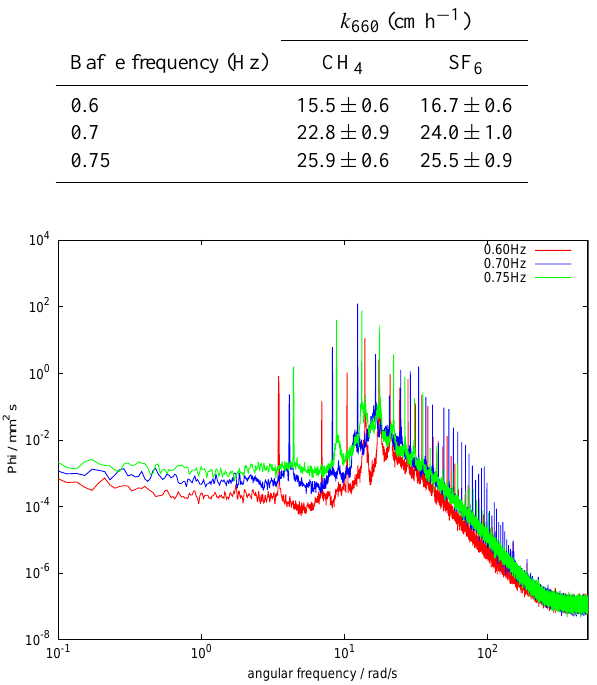
Figure 9. Wave spectra of a typical gas exchange experiment with Milli-Q water. The first peak for each boundary condition corre- sponds to the respective baffle speed, peaks at higher frequencies to